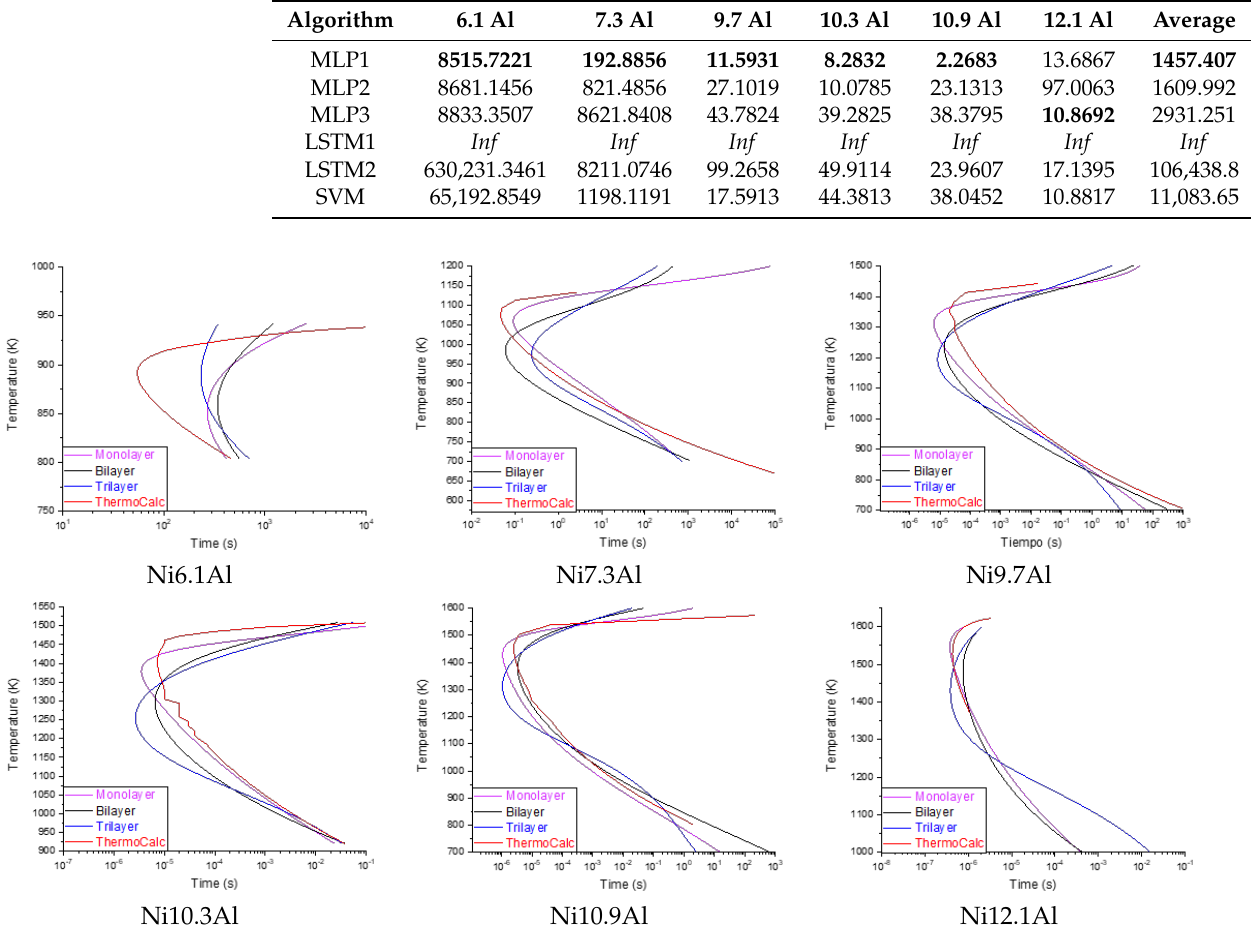
Figure 4. Complete curve prediction behavior of different MLP configurations against the results of Thermo-Calc™ for different chemical compositions. It is observed that the MLP monolayer has the best